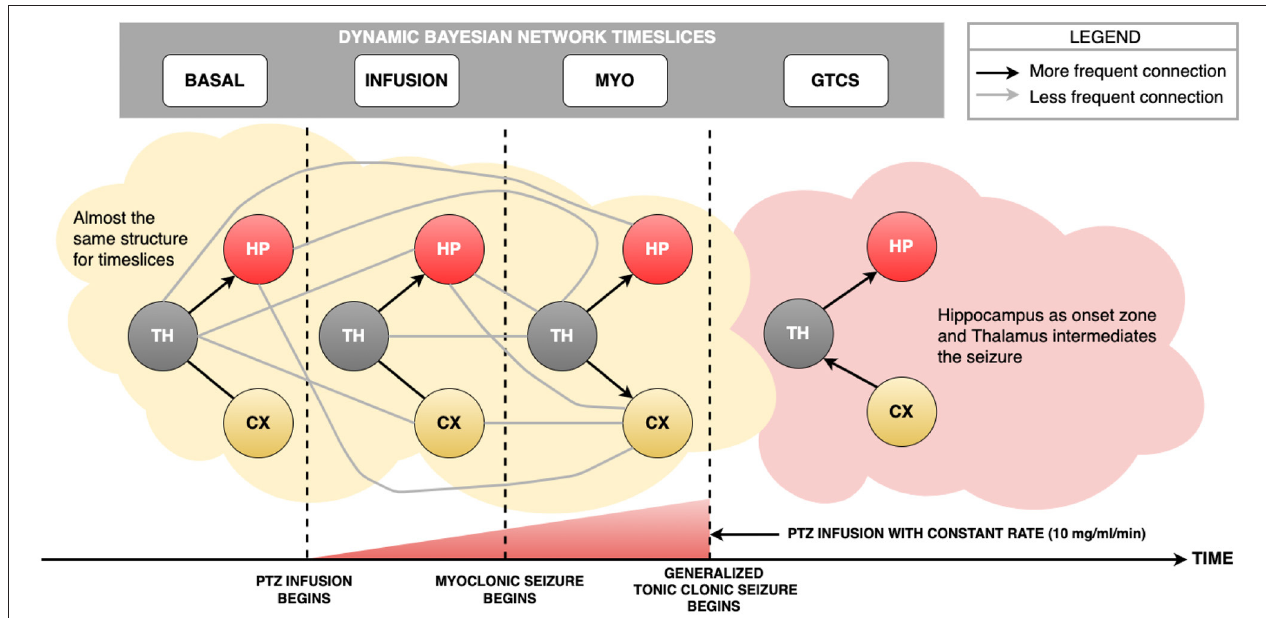
FIGURE 5 | The Dynamic Bayesian Network developed from LFP data set. The black arcs represent the strongest connections provided by analytical threshold model by Gross et al. (2019). The gray arcs represent connections that were not validated by analytical threshold model, but provided by DBN method. From Basal state until MYO time slice, there is a common pattern, i.e., Thalamus distributed information to Hippocampus and Cortex. This behavior is reported in literature, due to fact that knowledge about the role of Thalamus is an important communication lane to distribute information among brain areas. The novelty of the present study is that the same structure of communication is found during the MYO time slice. It was expected a transition structure closer to GTCS, but it did not happen. During GTCS time slice, there was a connection among HP, TH and CX change. It is possible to check that Hippocampus is the probable onset zone, once information reinforces synchronization from Thalamus. Another important path observed and reported in literature is that information from Cortex reverberates in the Thalamus is transmitted to the Hippocampus.